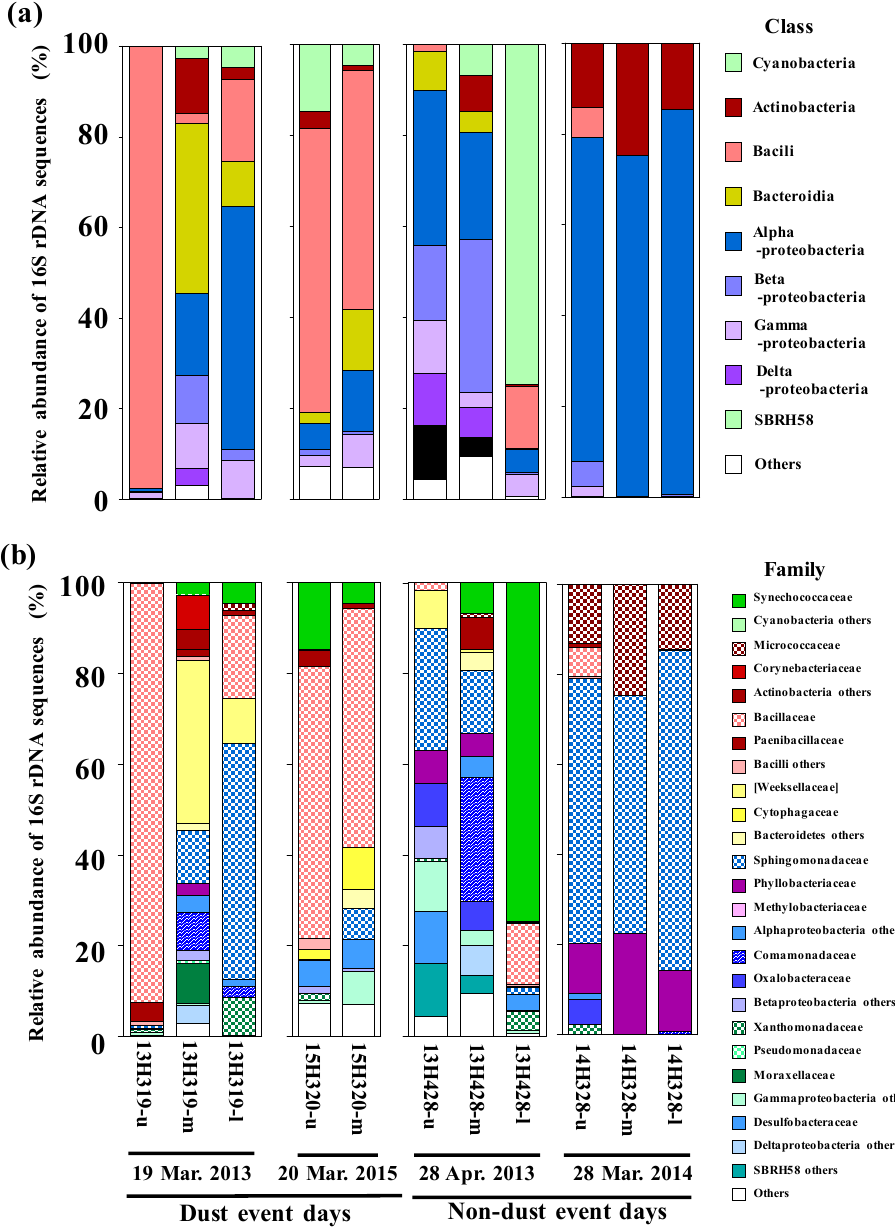
Figure 6. Vertical variations in bacterial compositions at (a) the class level and (b) the family level of the partial sequences obtained in the MiSeq sequencing database (ca. 400bp) obtained from air samples collected at different altitudes over the Noto Peninsula at dust-event